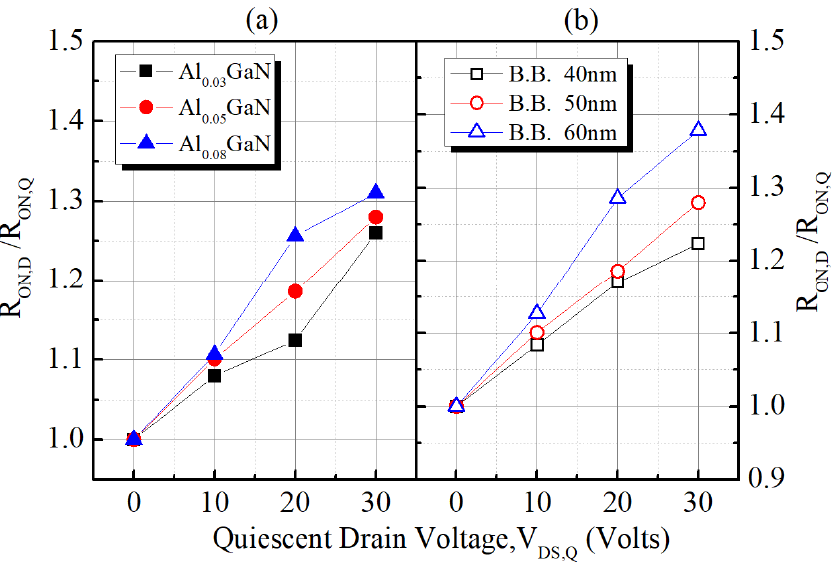
Figure 7. The dynamic Ron of devices, ( a ) the different Al mole fraction; ( b ) the different thickness of B.B. devices.